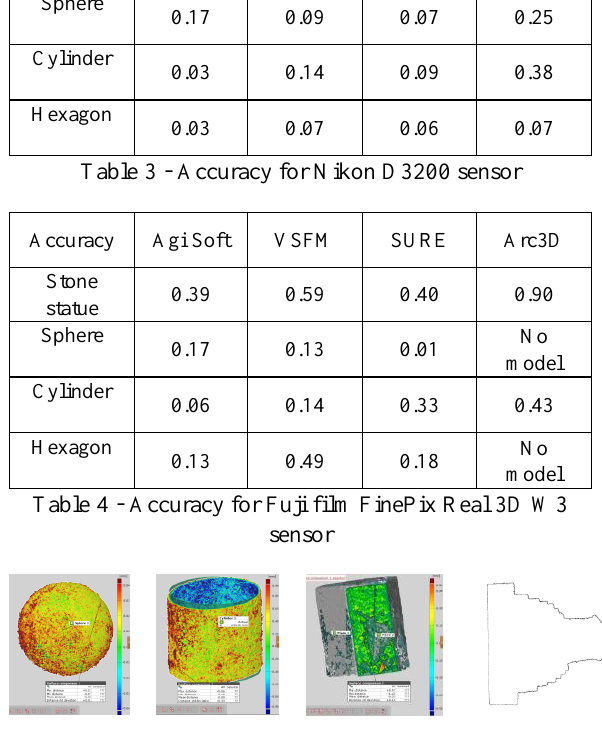
Figure 3 – Models that obtained from Stereo sensor and SURE